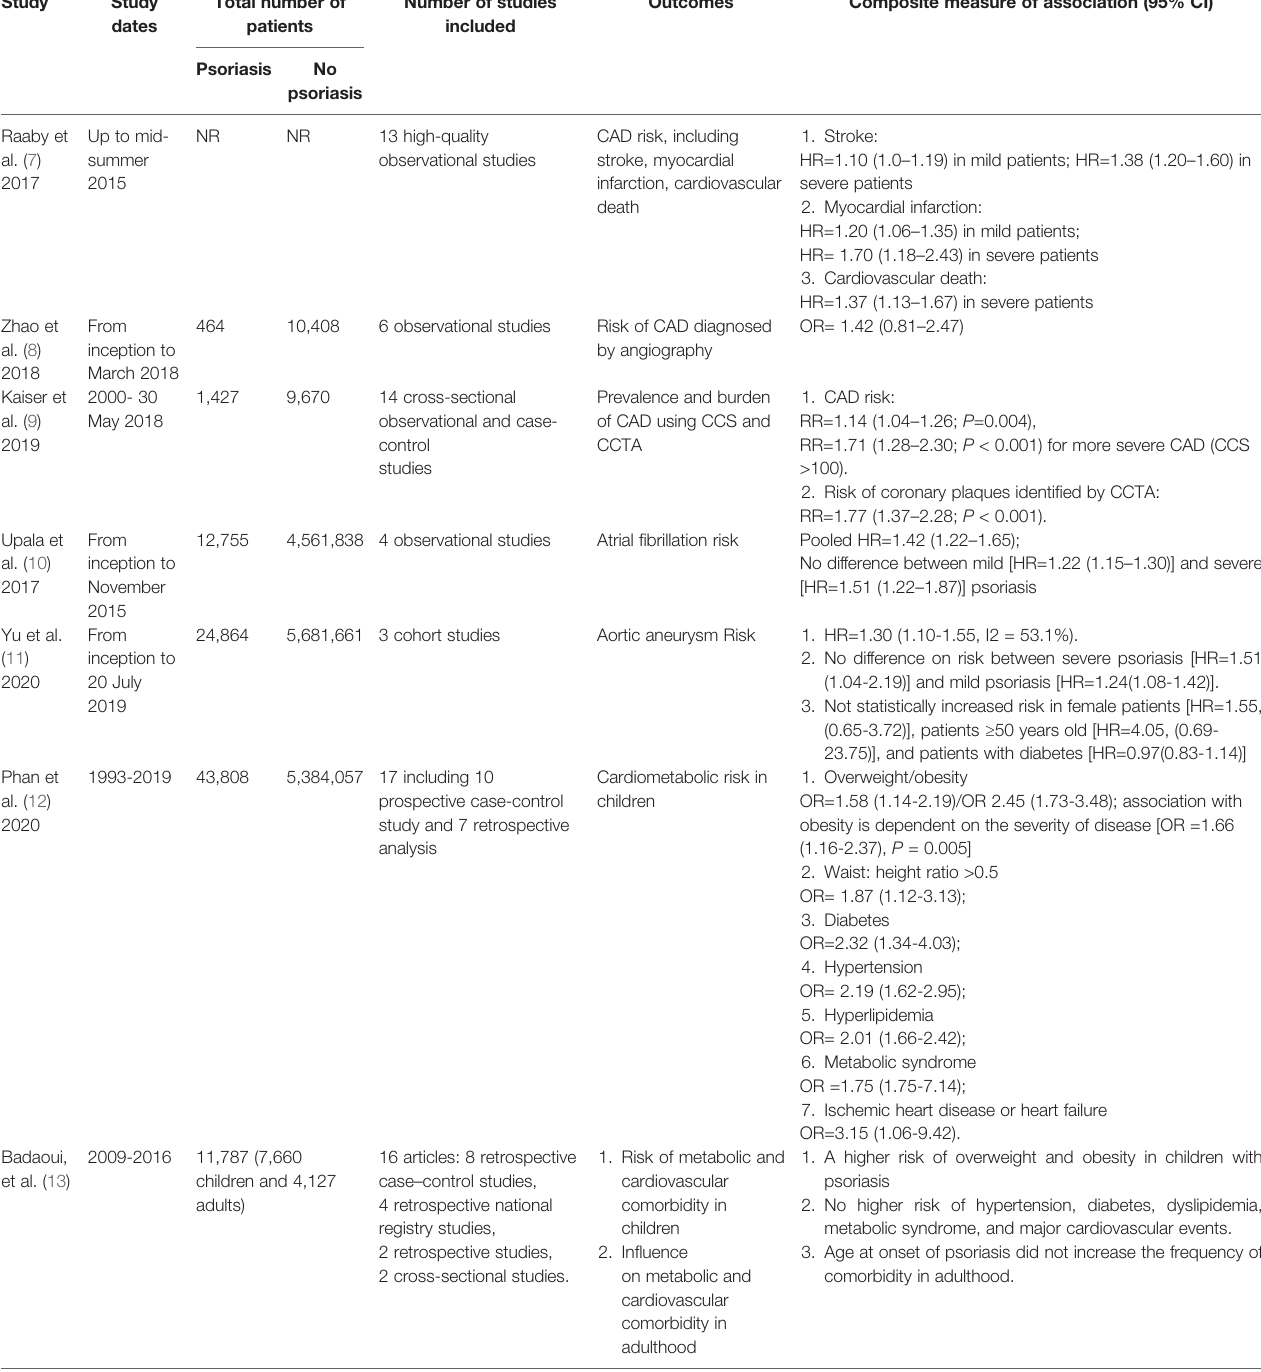
TABLE 1 | Summary of systematic review and meta-analyses assessing the association between psoriasis and cardiovascular